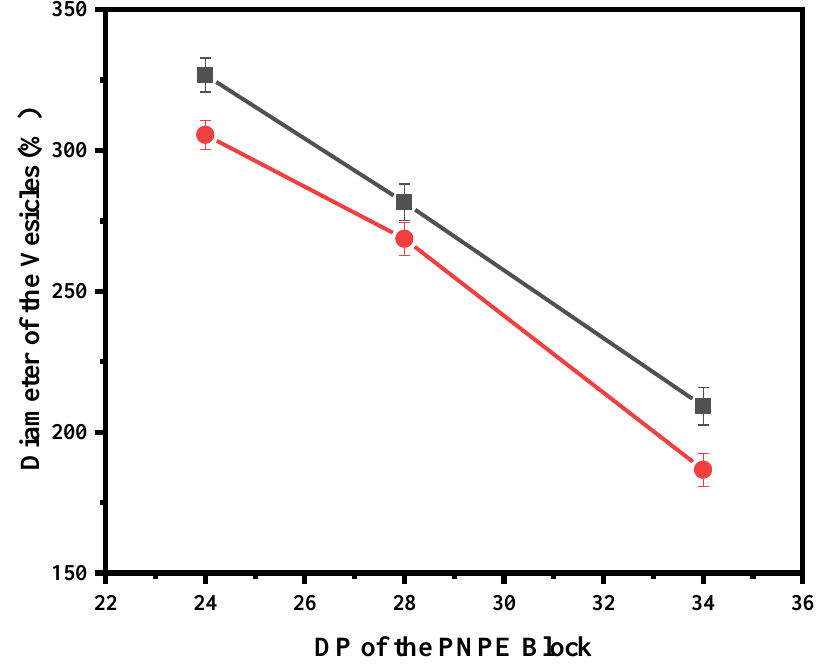
Figure 5. The relationship between DP(degree of polymerization) of the PNPE block and diameter of the vesicles as the DP of PNSN block is fixed at around 10. The red circle represents the results observed by TEM and the black square represents the results determined by dynamic light scattering (DLS).